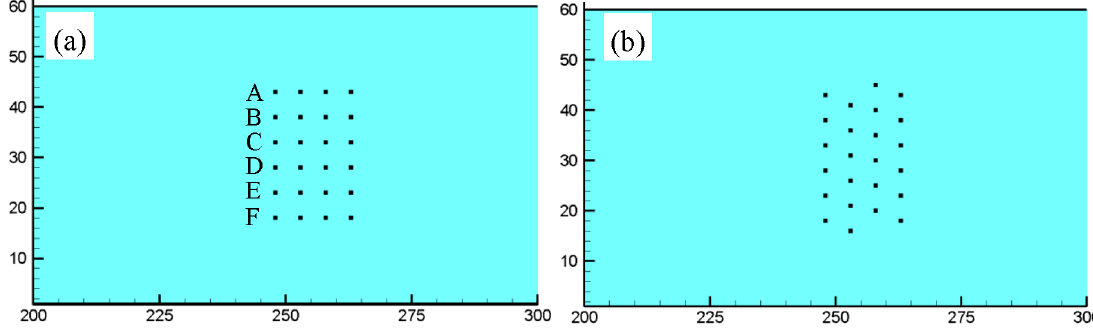
Figure 13. Layouts of ( a ) the in ‐ line, regularly ‐ spaced array and ( b ) the staggered array.